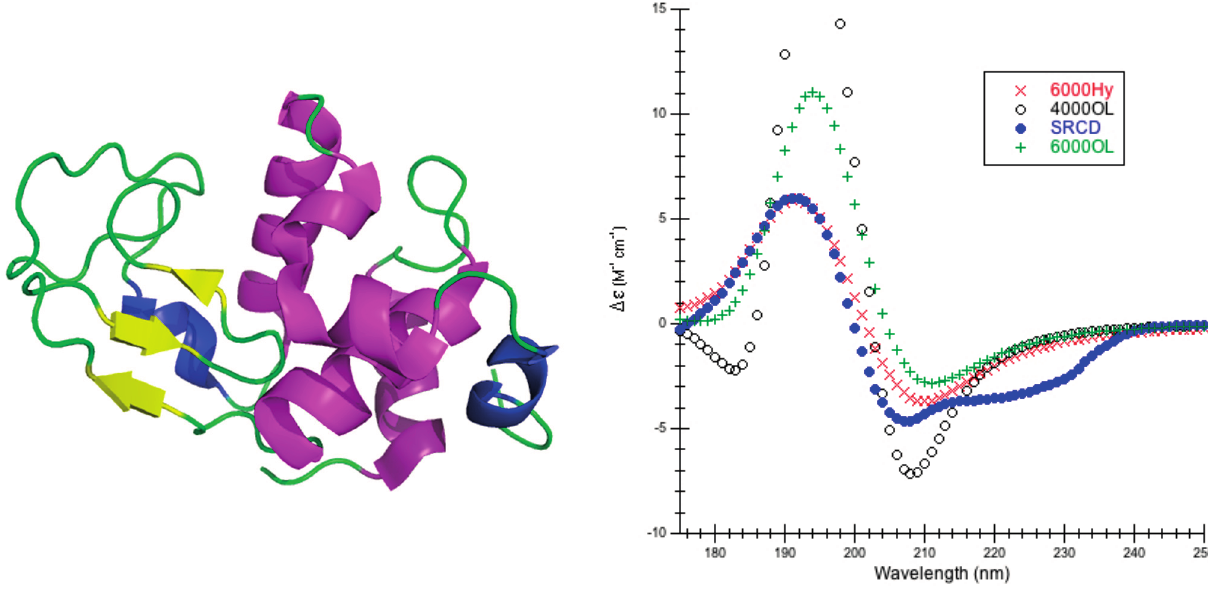
Figure 1. Lysozyme. ( Left ) Secondary structure of lysozyme (PDB code 2VB1 [56]) is shown: thick purple cartoons/coils correspond to α -helices (4–15, 24–37, 88–100, 108–115), the short blue cartoons/coils correspond to 3 10 -helices (80–85, 108–115) the yellow tapes are β -sheets, (43–45, 51–53, and 58–59) and the thin green ropes are turns and other structures; ( Right ) Predicted CD Using CDCALC and 2VB1 Minimized via NAMD/ CHARMM22. Calculated spectra ignore all CH 3 hydrogens. The 6000 and 4000 refer to